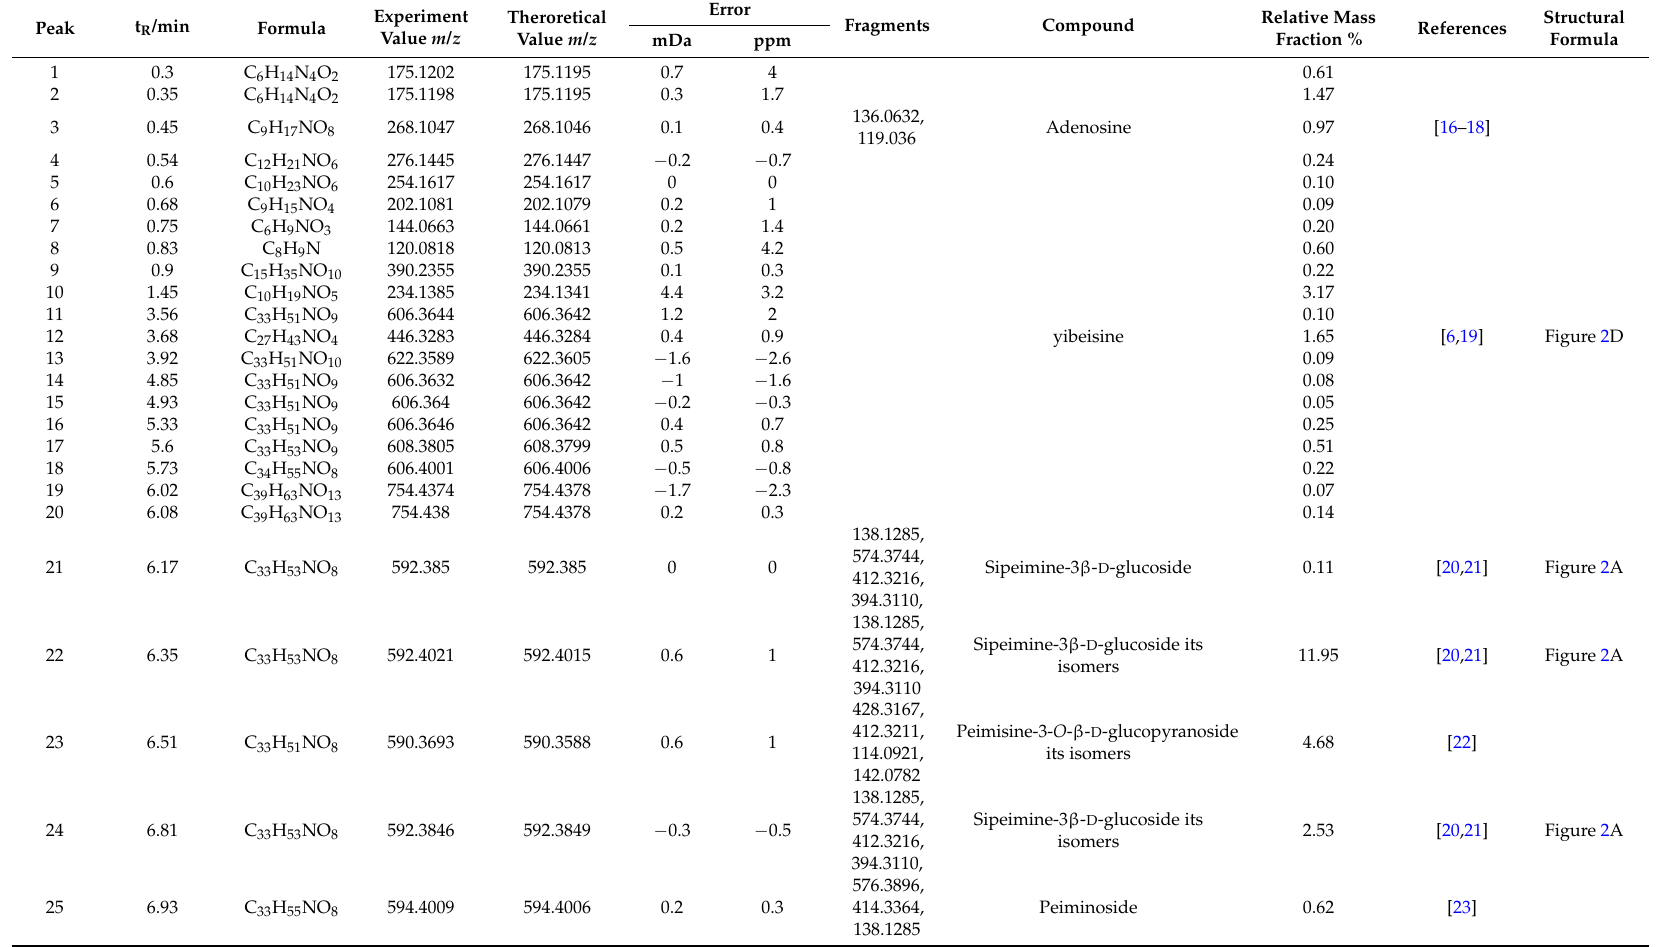
Table 1. Result of chromatographic peak identification of wild Fritillaria (Gongliu County, Yili)